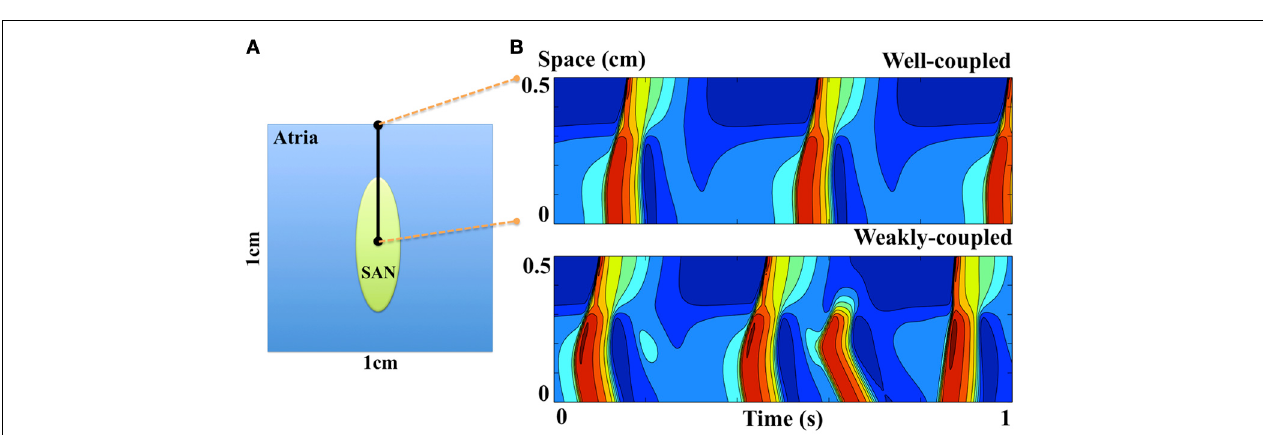
FIGURE 11 | (A) Model schematic of a simplified 2D SAN model. (B) Space-time plots of SAN and atrial excitation patterns when the SAN is either weakly or well coupled to atrial tissue. The